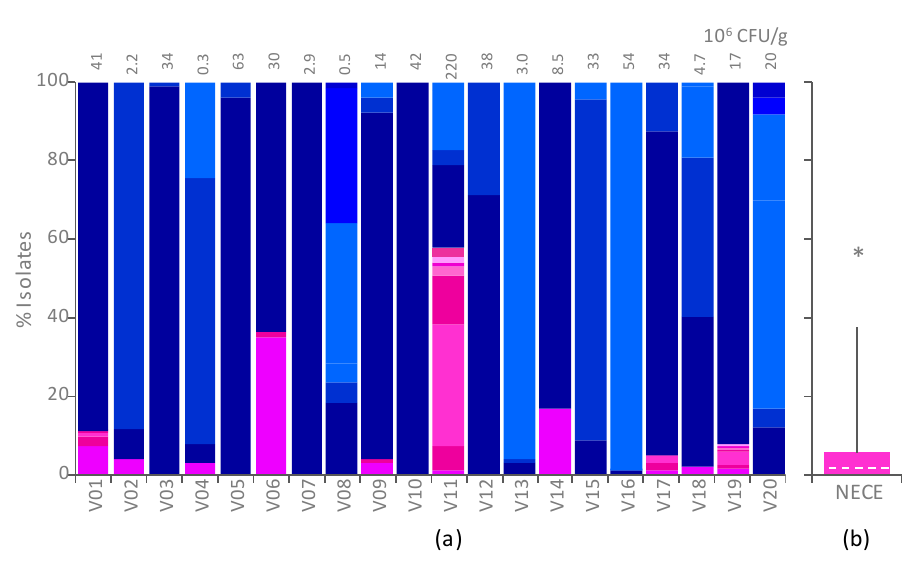
Figure 1. Counts of Escherichia coli and non- Escherichia coli Enterobacterales (NECE), enumerated onto HiCrome Coliform Agar (HCCA) plates. ( a ) Percentage of colonies attributed to E. coli (blue shades) and NECE (pink shades) in the feces of 20 subjects. For each subject, di ff erent shades indicate di ff erent biotypes according to enterobacterial repetitive intergenic consensus-PCR (ERIC-PCR) and random amplification of polymorphic DNA-PCR (RAPD-PCR) fingerprinting. The total count of Enterobacterales ( E. coli + NECE) is reported in the top margin. ( b ) Distribution of the percentage of NECE colonies. The median (dashed line), the 25th and 75th percentiles (colored box), the 10th and 90th percentiles (whiskers), and outliers (*) are indicated.